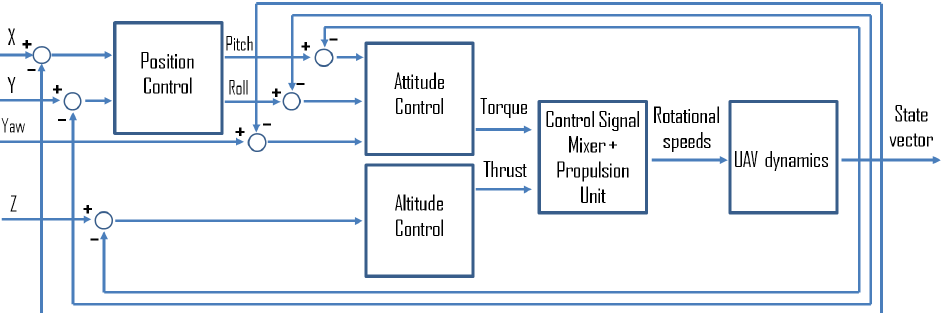
Figure 4. A block diagram of the coaxial quadrotor